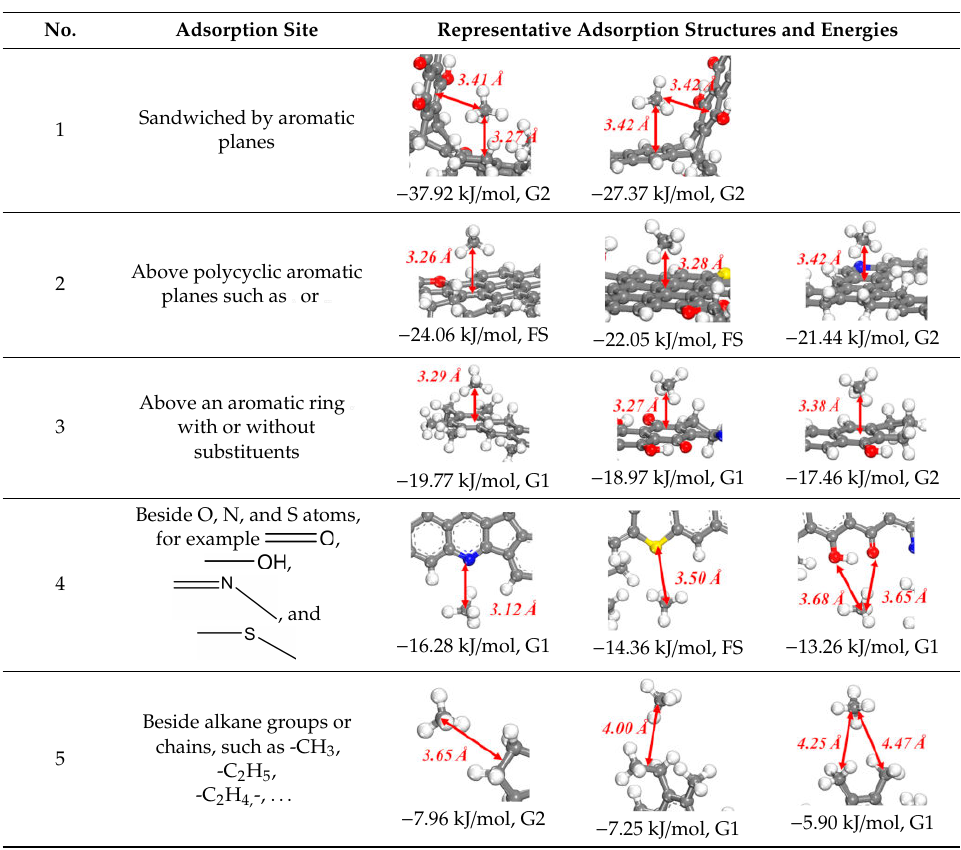
Table 2. CH 4 adsorption structures and energies on di ff erent types of adsorption sites of coal. For each adsorptionstructure, theadsorptionenergy(inkJ / mol)andthenameofthecoalmolecule(thecodenames G1, G2, and FS refer to Given type 1, Given type 2, and FS, as shown in Figure 1a–c,